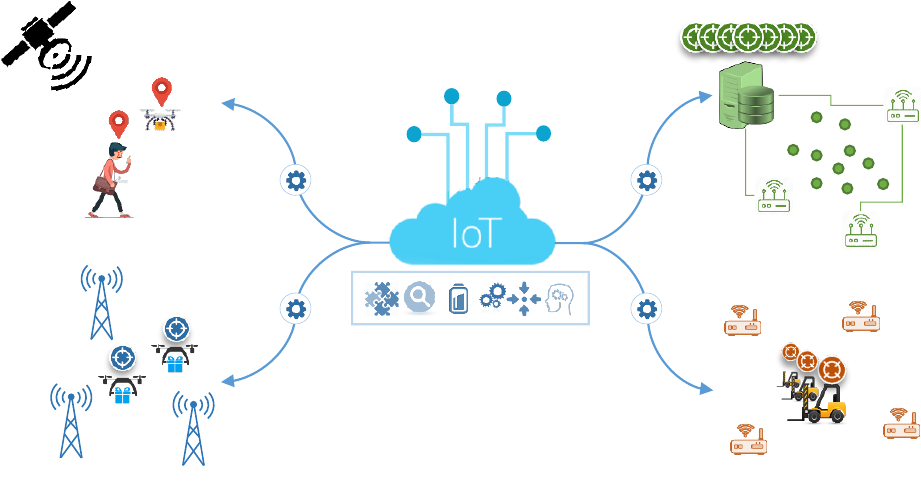
Figure 3. The integration of localization